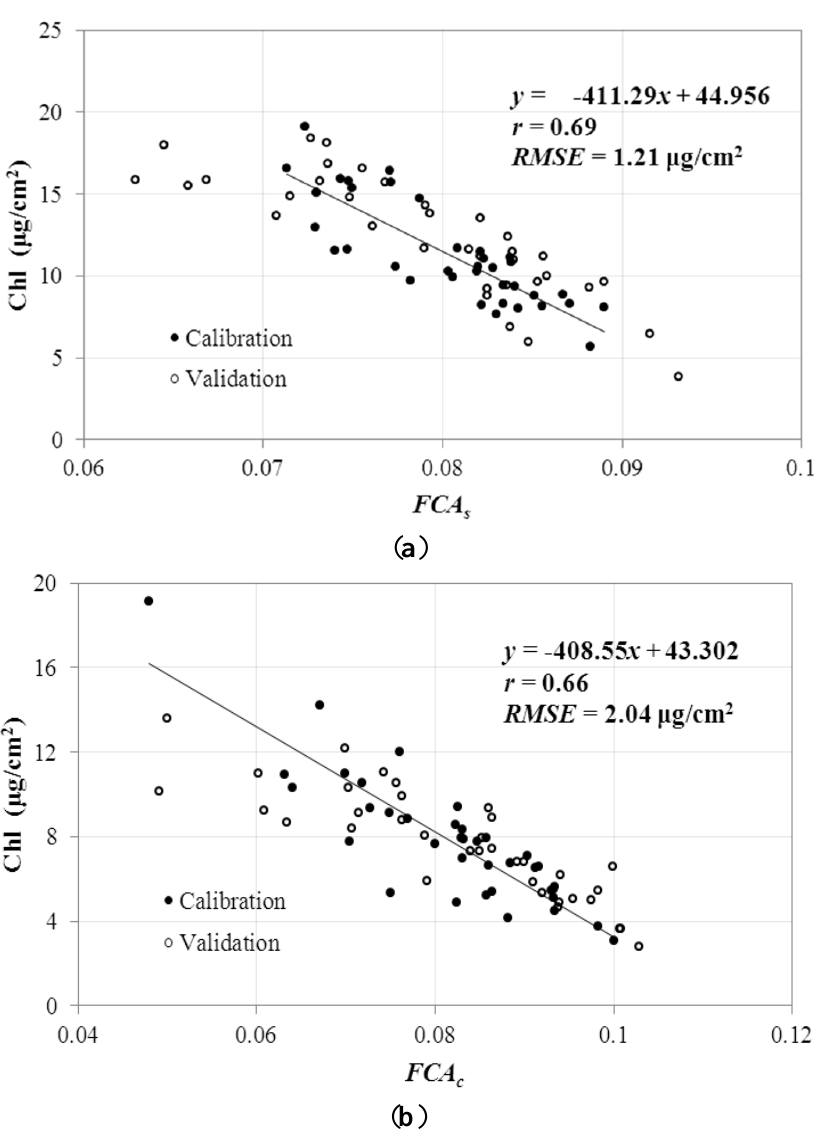
Figure 4. Relationships between FCA and leaf chlorophyll content (Chl): ( a ) soybean; ( b )